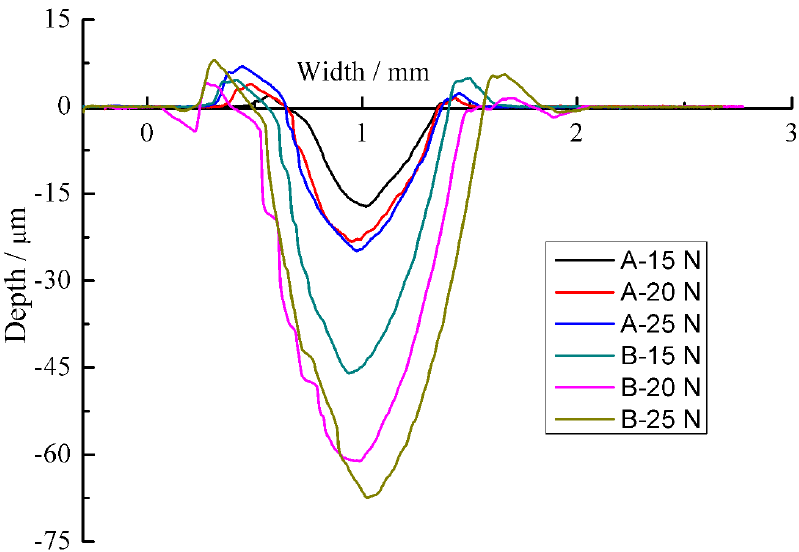
Figure 10. Two-dimensional (2D) profiles s of the cross-section of the wear scars.